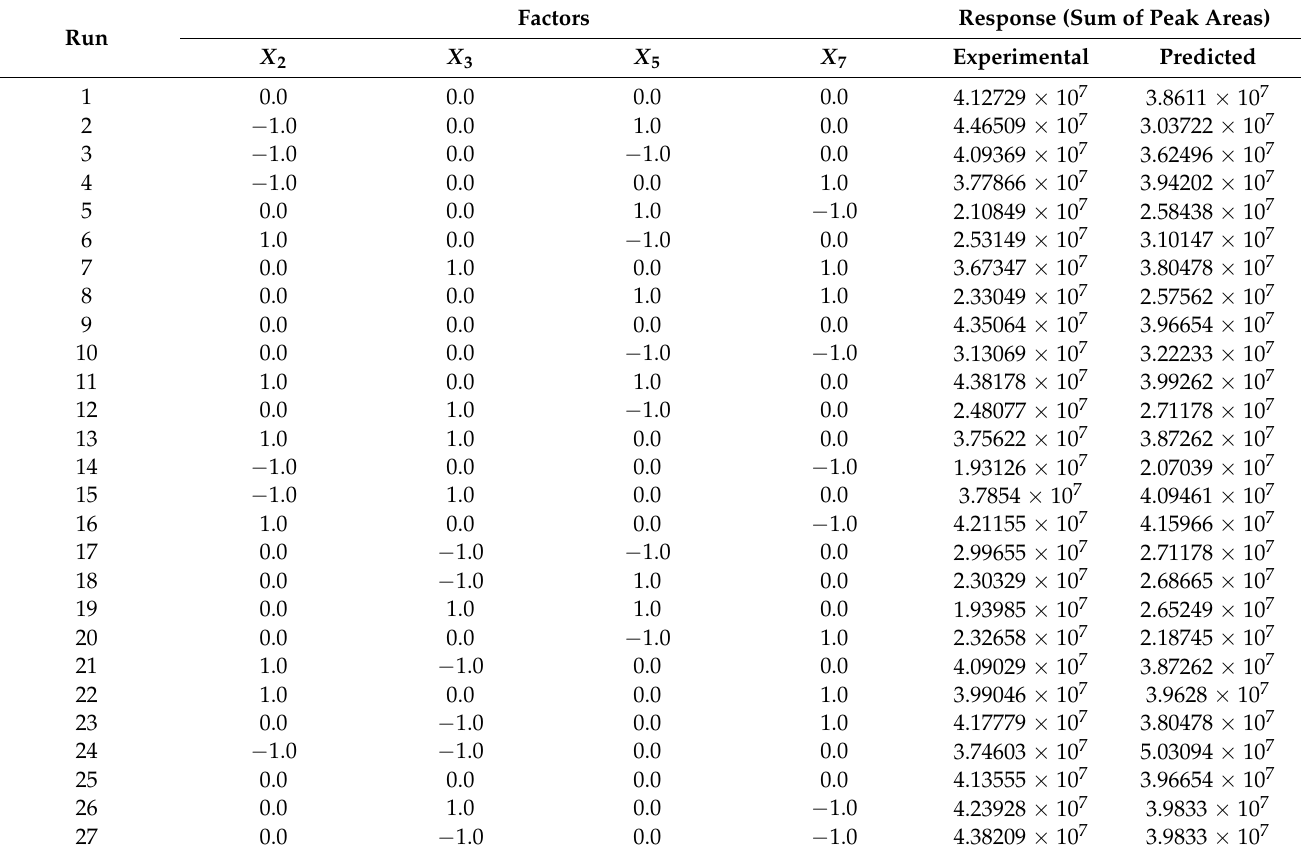
Table 2. Actual and predicted values of the standardized areas based on the Box–Behnken surface- response design of the enzymatic